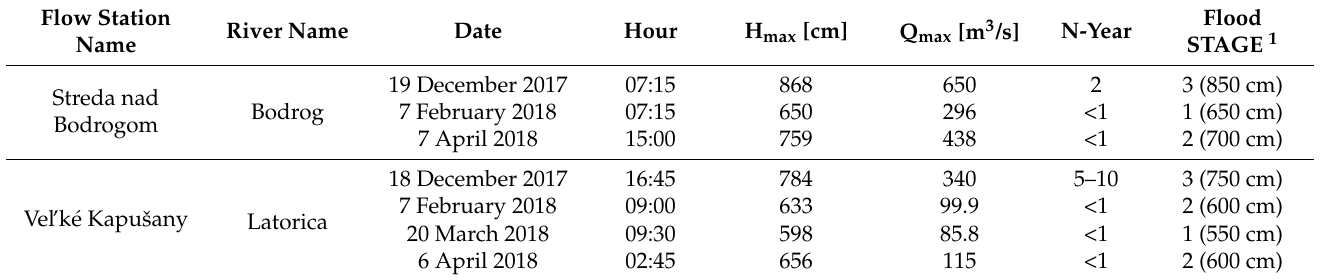
Three sites of interest characteristic in significant flood changes were selected to obtain the most accurate results (Figure 3).